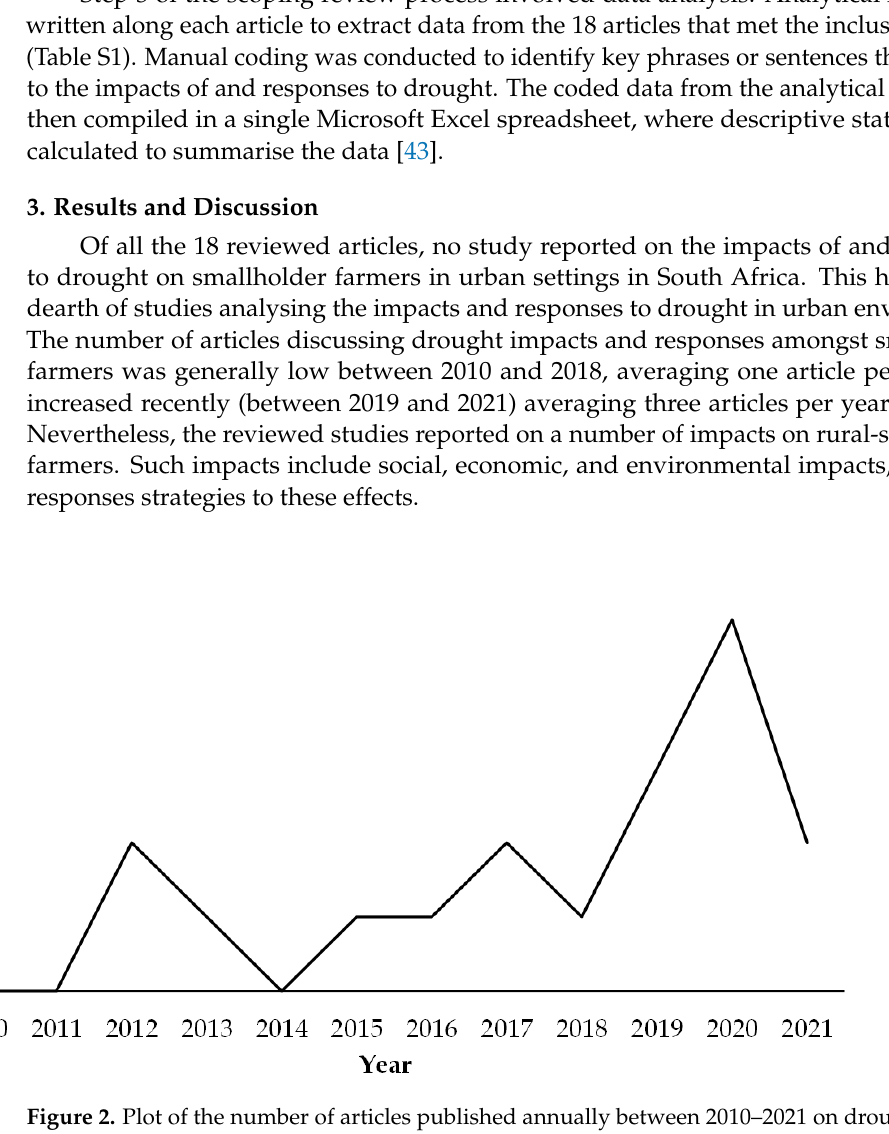
Figure 2. Plot of the number of articles published annually between 2010–2021 on drought impacts and responses amongst smallholder farmers in South Africa.